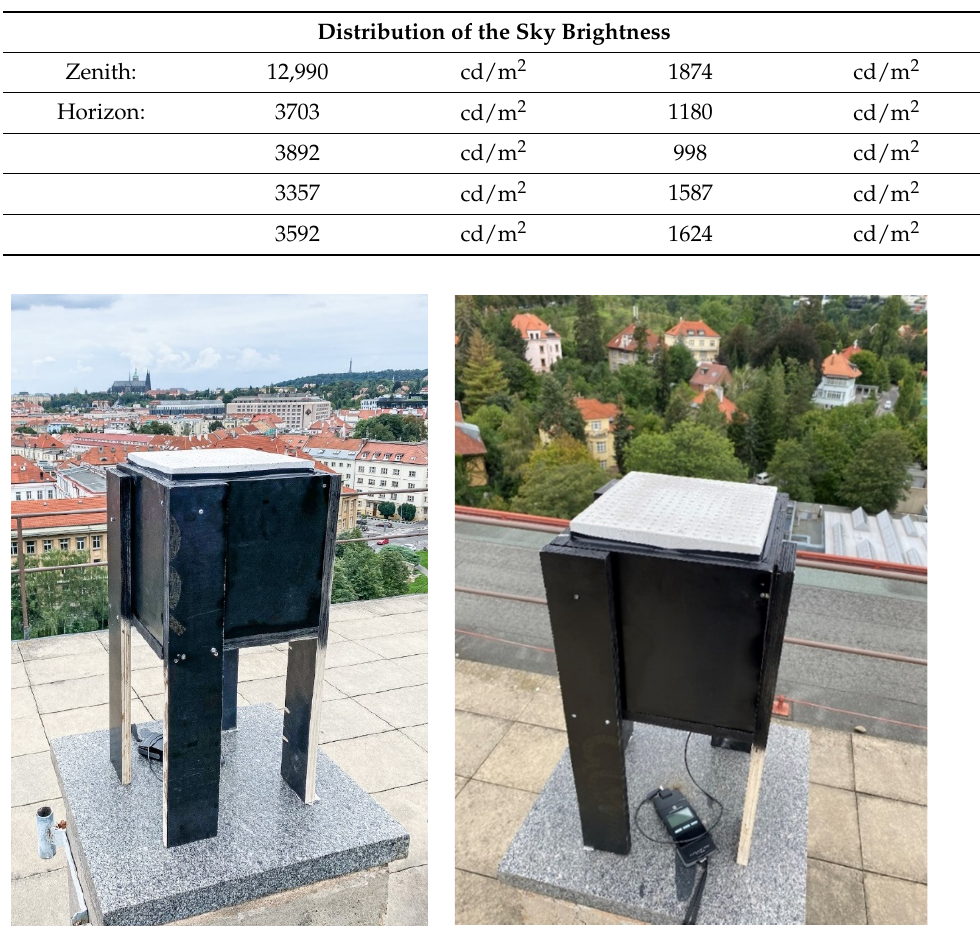
Figure 24. Down-scaled model for measurements. Table 5. Distribution of the sky brightness.